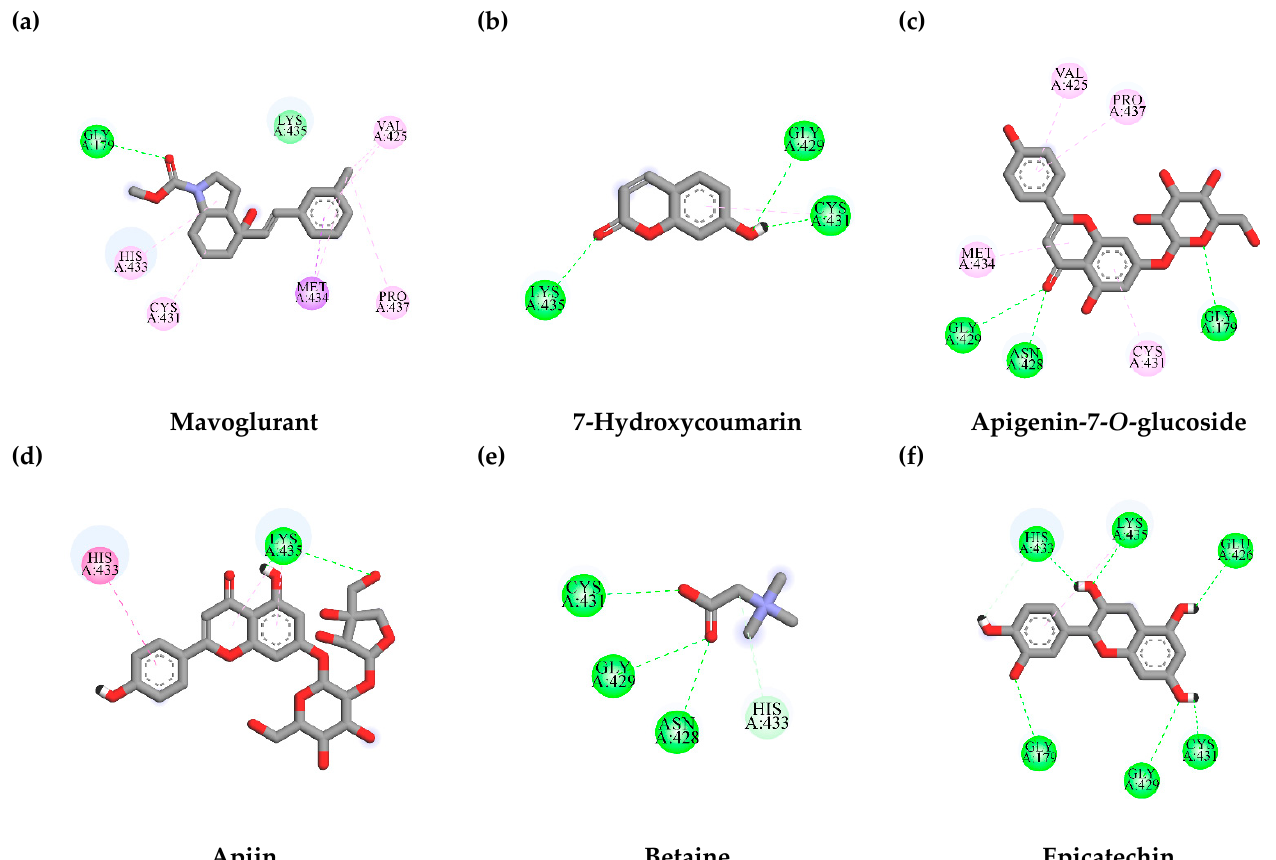
Figure 9. Schematics of amino acid interactions of E3 ubiquitin-protein ligase parkin and candidate ligands: ( a ) mavoglurant, ( b ) 7-hydroxycoumarin, ( c ) apigenin-7-O-glucoside, ( d ) apiin, ( e ) betaine and ( f ) epicatechin. Green, pink and orange dashes indicate hydrogen, hydrophobic and electrostatic bonds, respectively. Table 5. Physicochemical properties of TLE phytochemical compounds based on Lipinski’s rule of five